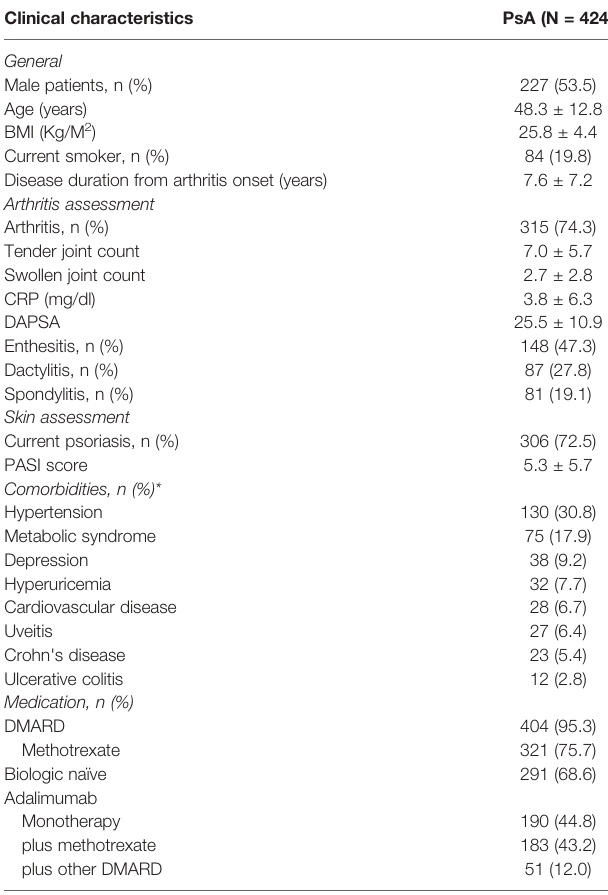
TABLE 1 | Baseline clinical characteristics of psoriatic arthritis patients. Clinical